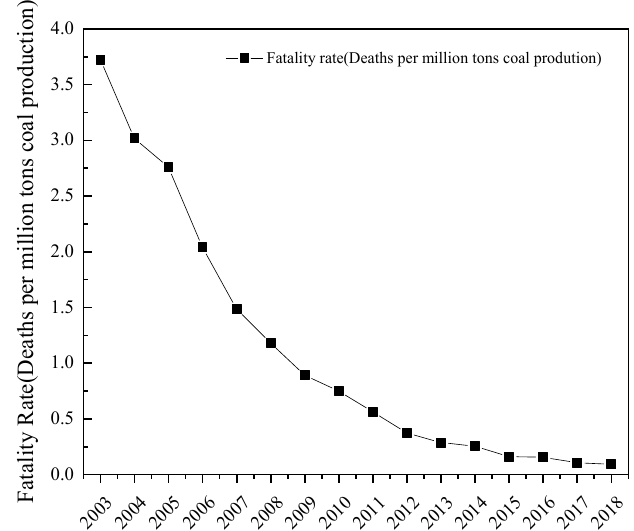
Figure 2. Changes in the fatality rates in coal mines from 2003 to 2018. In terms of gas accidents, from 2003 to 2018, there were 2984 gas accidents in China, with 12,807 deaths (Table 1), accounting for 11.66% and 30.18% of the total number of coal mine accidents, respectively. The specific data analysis is presented in Section 4. Table 1. Statistics of gas accidents from 2003 to 2018. Year